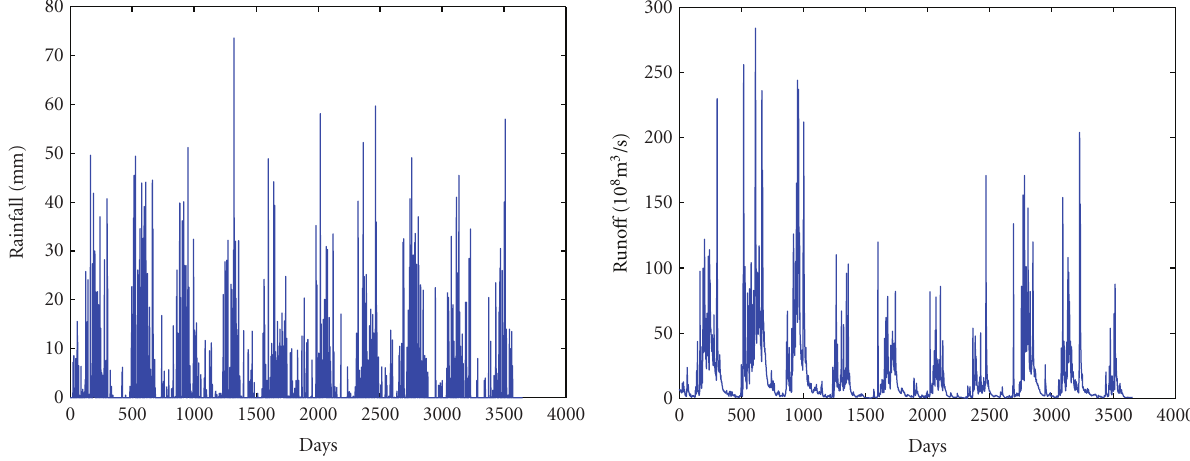
Figure 2: Time series plots of the observed rainfall and runo ff values.